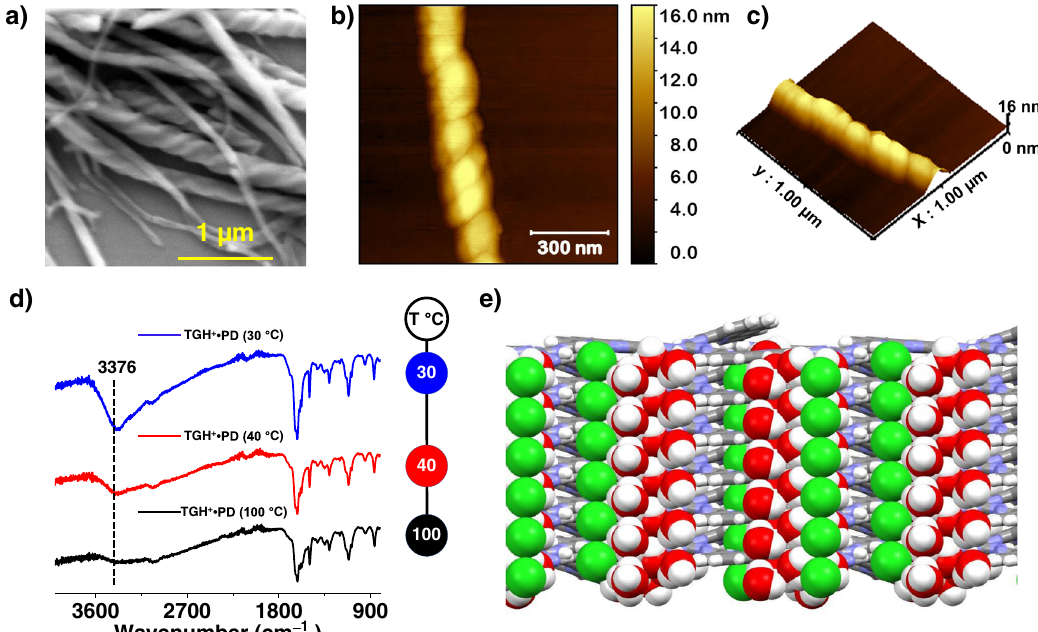
Fig. 2 Microscopic characterization of TGH + (cid:129) PD. a SEM, b AFM, and c 3D AFM images of the TGH + (cid:129) PD-based helical fi bers. d Superimposed variable- temperature FTIR spectra of TGH + (cid:129) PD showing the disappearance of water molecules upon heating. e Perspective view of the modeled COF layers along the screw axes illustrating the interactions between counterions, water molecules, and the COF